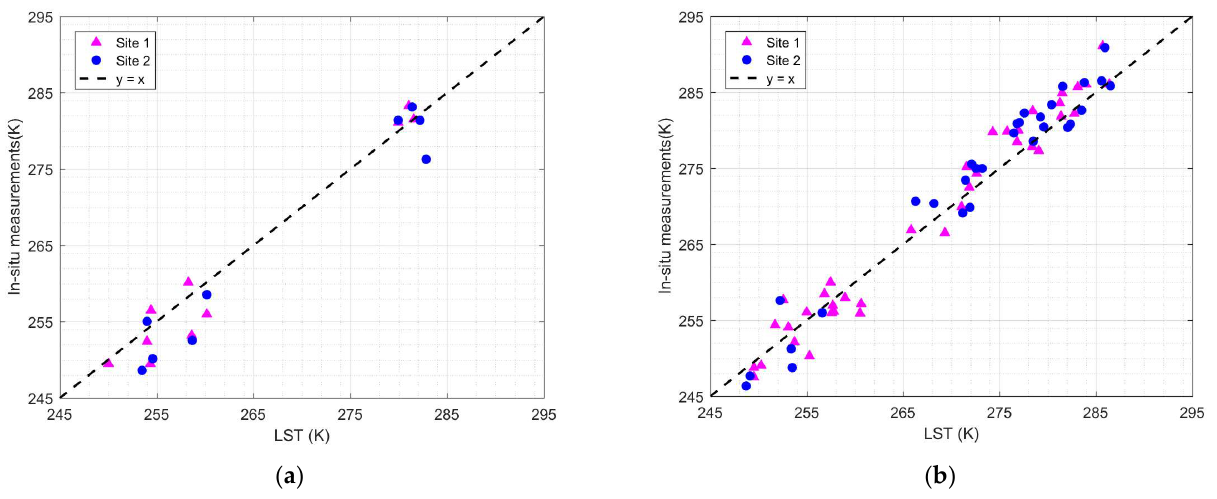
Figure 3. The scatter plots for nighttime temperature at the SFP sites using 30 m LST and in situ measurements from January to October 2019: ( a ) Terra/MOD (around 10:00 p.m.); ( b ) Aqua/MYD (around 2:00 a.m.).